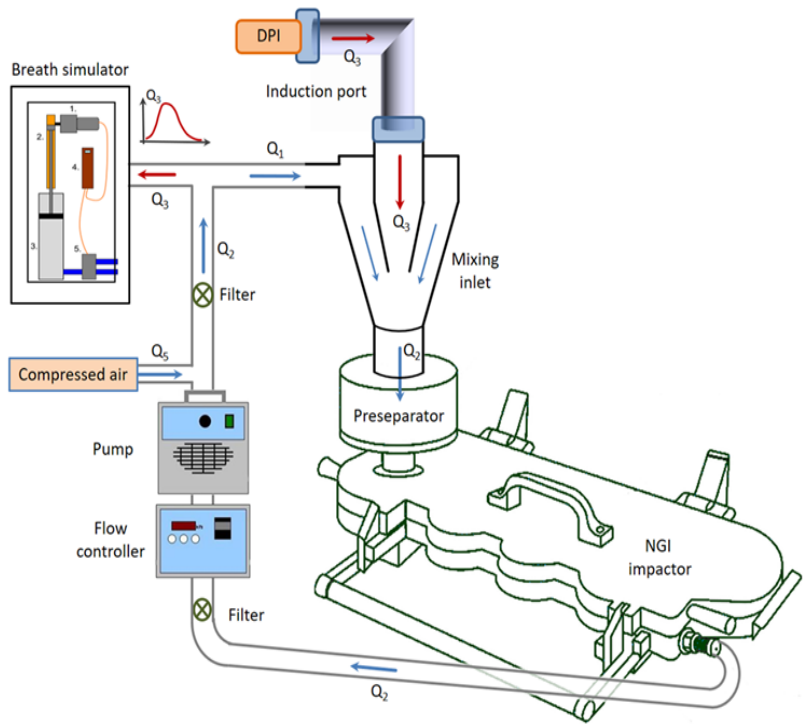
Figure 1. The schematic design and components of the measurement setup: DPI, induction port, NGI, vacuum pump with a critical flow controller, and mixing inlet.